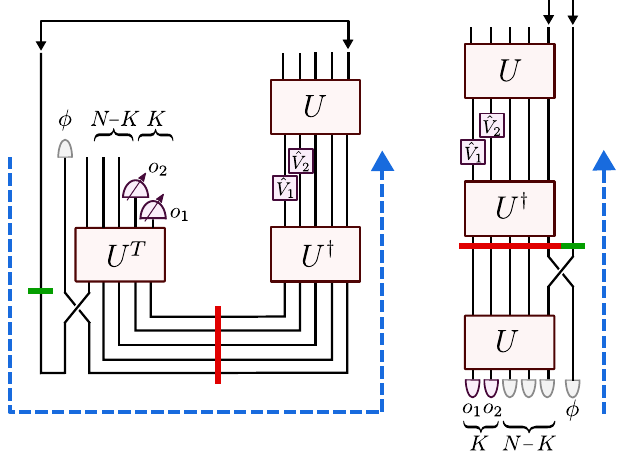
FIG. 6. One-sided implementation (right) of the original two- sided teleportation protocol (left), derived using repeated appli- cations of Eq. (9) [replacing U → U T for convenience, compared to Fig. 1(a)]. Blue arrows denote the sequence of operations in the one-sided protocol, the green band marks the teleported qubit and its corresponding component in the one-sided protocol, and the red band marks the initial EPR state and its corresponding